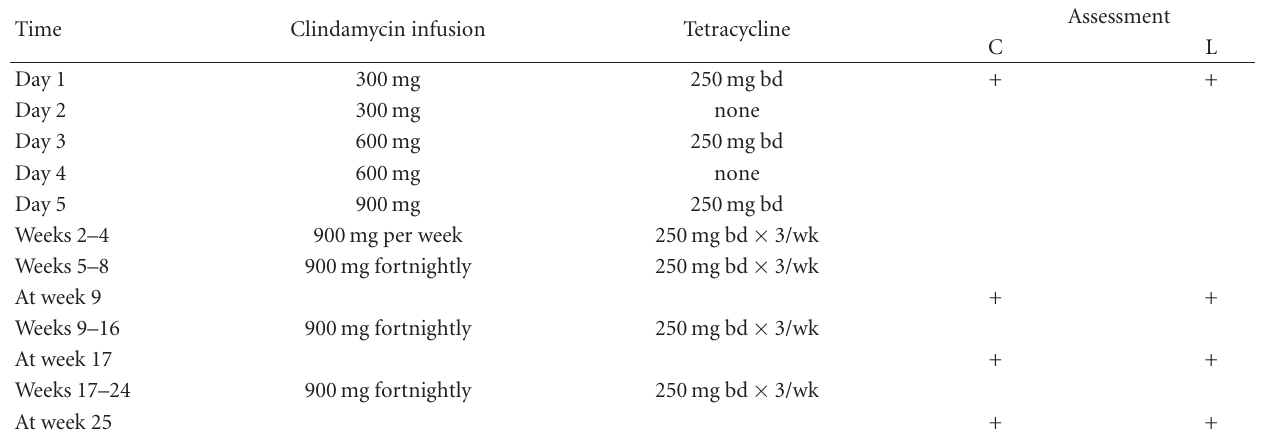
Table 1: Treatment and assessment regimes for patients in Group I (active treatment). Clindamycin infusions were given in 250 mL normal saline over one hour. Patients in Group II (placebo) received placebo infusions of normal saline and placebo tablets according to the same regime; they had the same assessment regime. bd: taken twice a day (morning and evening). × 3/wk: three times per week. Assessments: C, clinical; L,